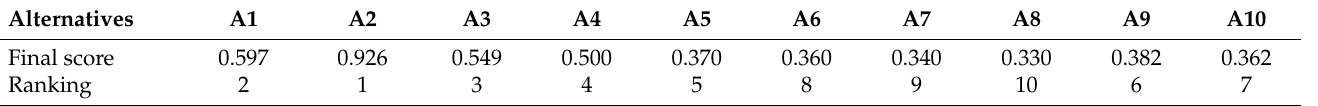
Table 10. Ranking